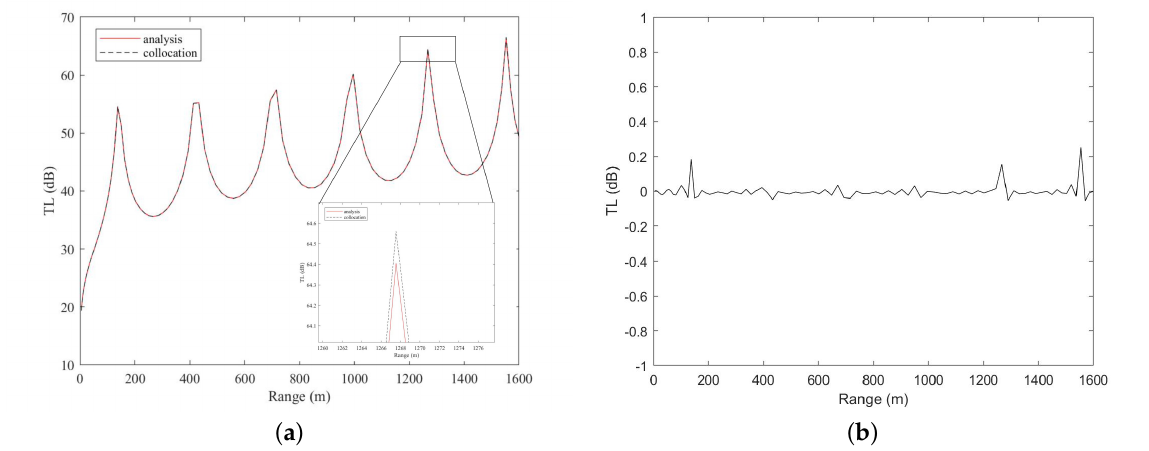
Figure 4. TL field of an ideal fluid wave: the result of the analytical solution ( a ), the result of the collocation method ( b ).